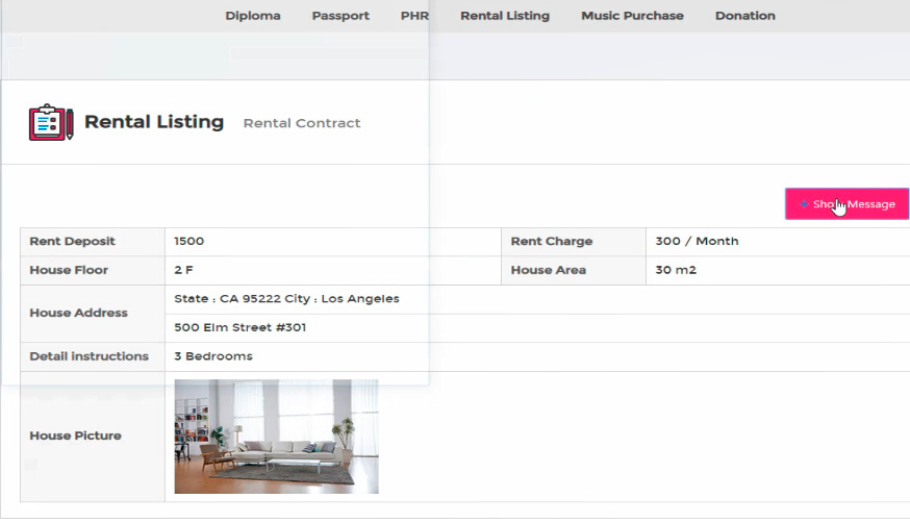
Figure 12. Main screen of Blockchain in smart contract real estate transactions.